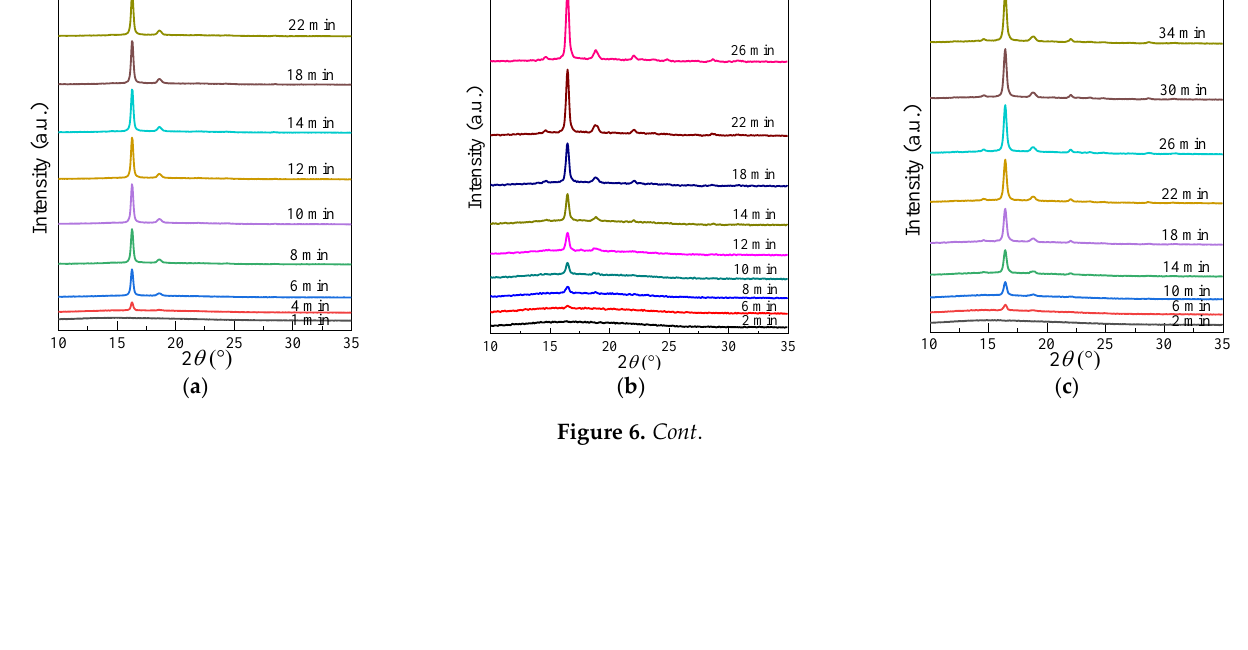
Figure 6. WAXD diffraction patterns of PLLA isothermally crystallized for various time at ( a ) 100 °C; ( b ) 110 °C; ( c ) 120 °C; and ( d – f ) are the crystallinity of PLLA calculated from ( a – c ), respectively, with crystallization time.